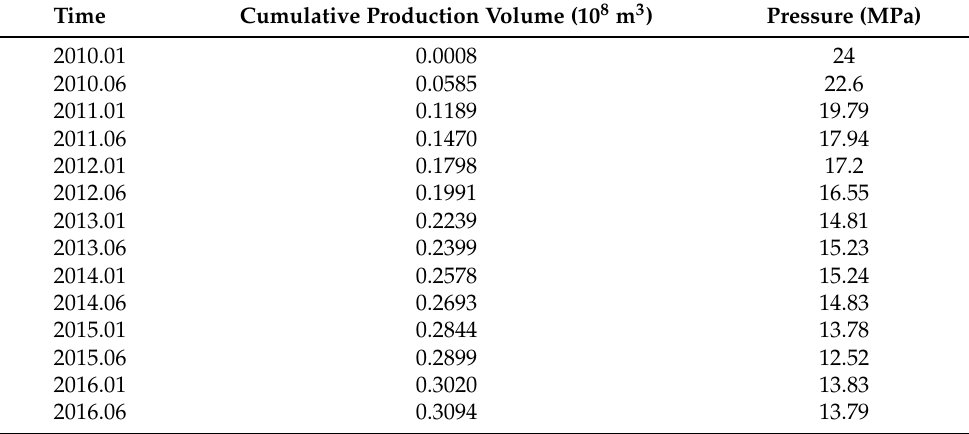
Table A6. Production history data of well